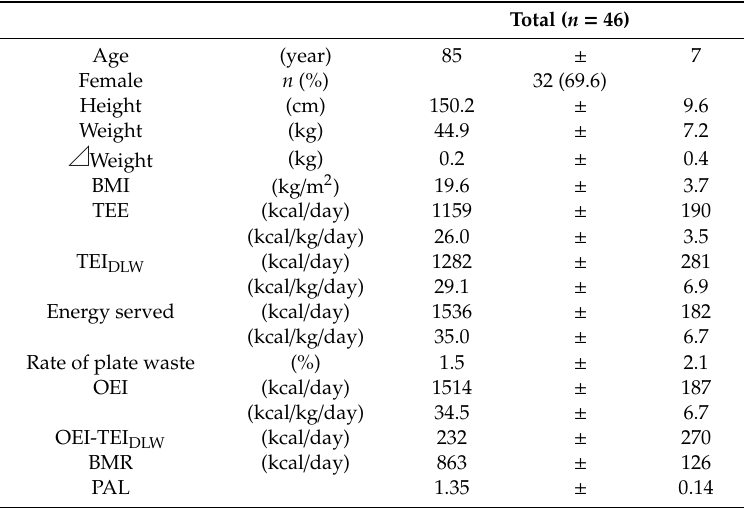
Table 1. Baseline characteristics and energy variables (analysis 1).